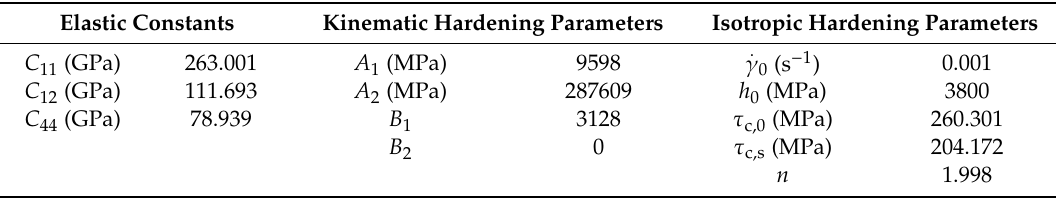
Table 2. Material parameters for the crystal plasticity model, including elastic constants and parameters for cyclic hardening.